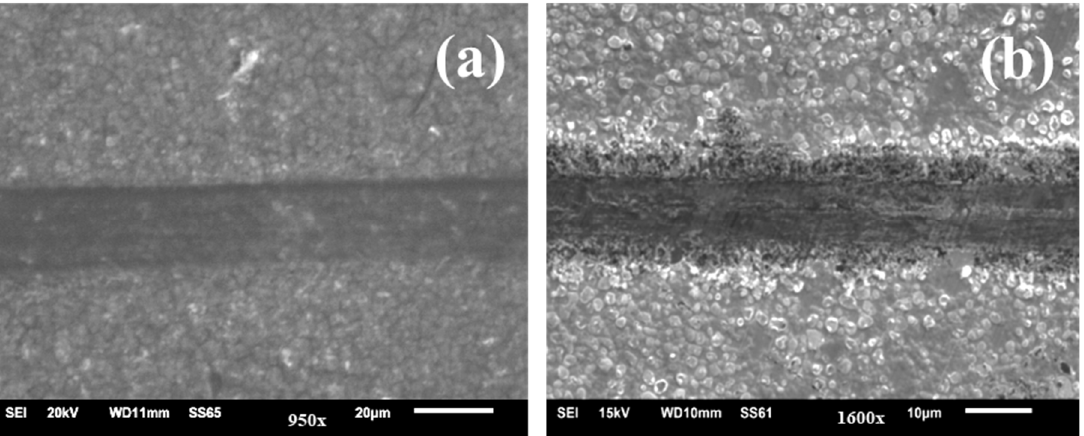
Figure 7. SEM image of the wear track of TaN/Cu nanocomposite coating with ( a ) 10.46 at.% and ( b ) 25.54 at.% copper content.